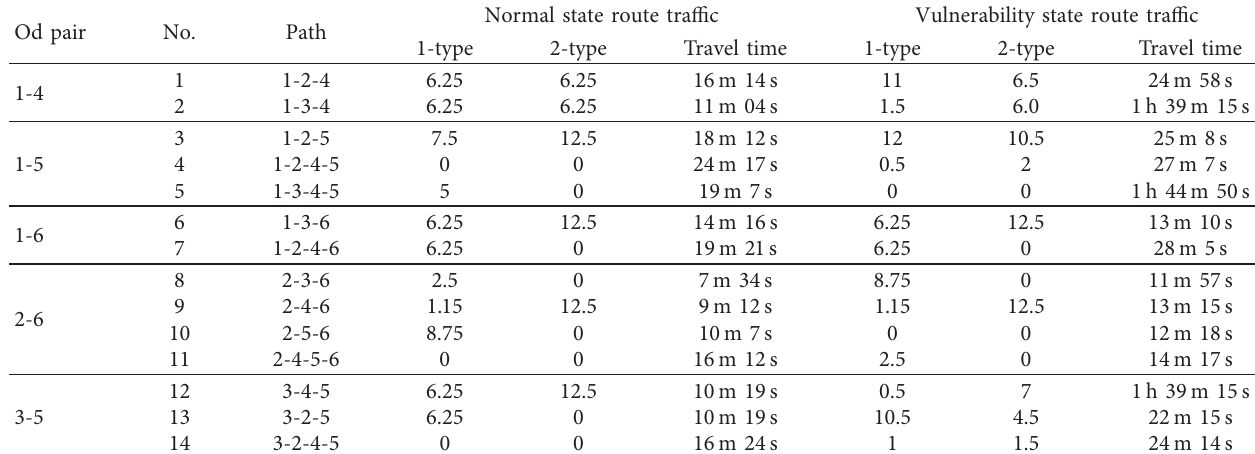
Table 2: Deterministic equivalent equilibrium flow mode with negative